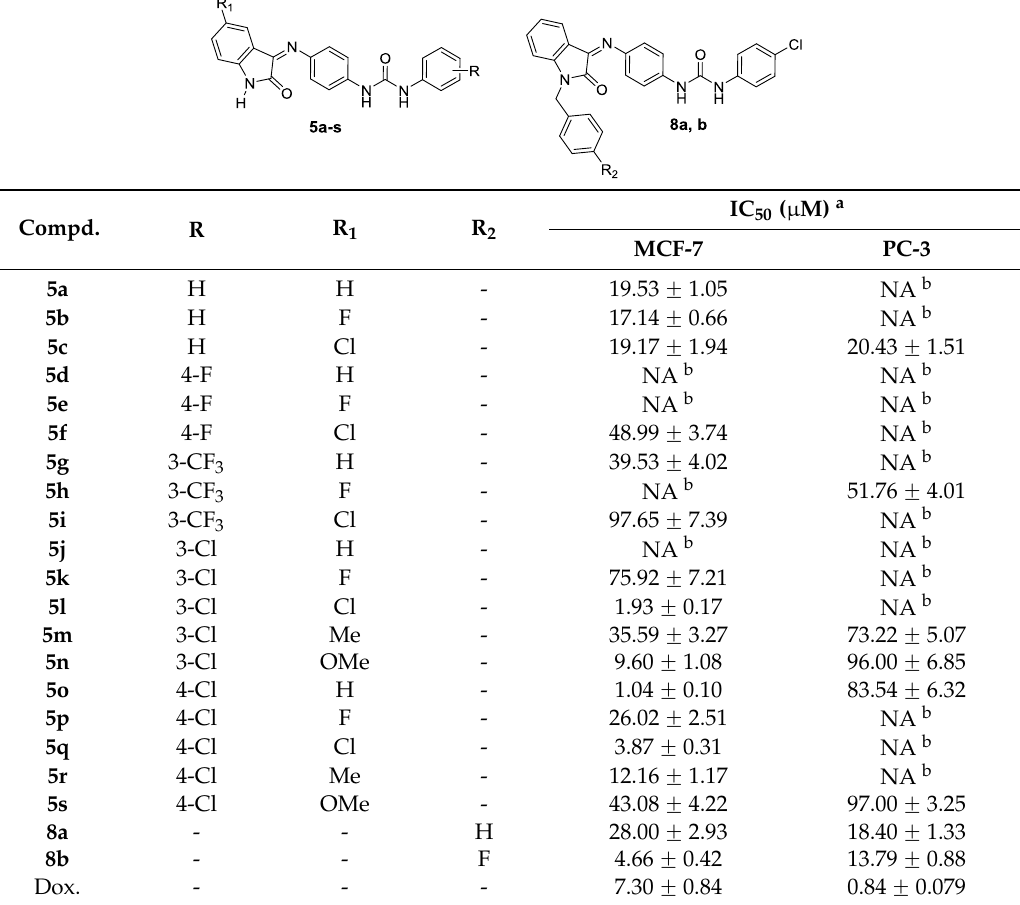
Molecules 2016 , 21 , 762 Table 1. In vitro cytotoxic activities of the synthesized derivatives against MCF-7 and PC-3 cell lines.